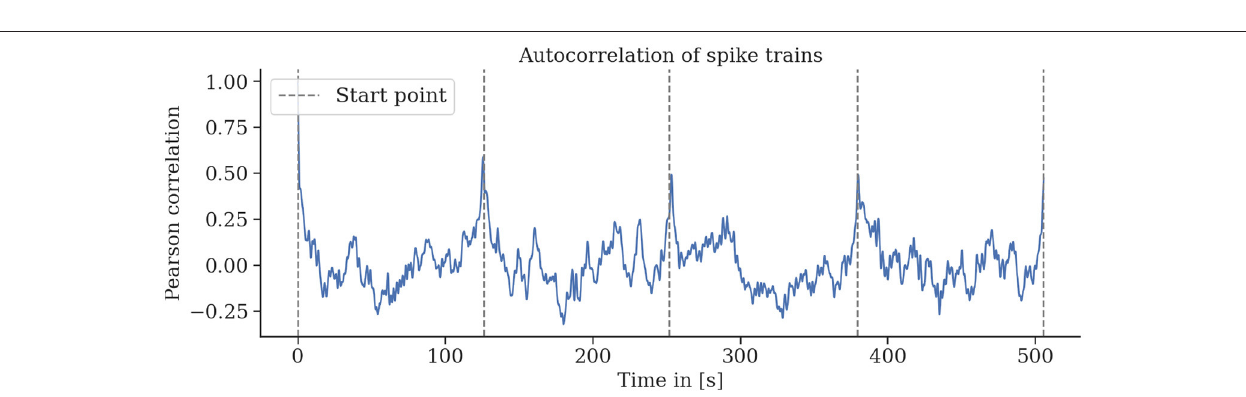
FIGURE 9 | Spike rates are strongly autocorrelated for multiple repetitions of the same flight trajectory. Sliding-window autocorrelations were computed for all rounds of six (a–f) flights. For all flights, particularly for flights a, b, and d, strong correlations of spike activity were observed for several rounds of the same flight trajectory. Gaps between rounds and the starting and landing periods were removed, and the sliding Pearson correlations were computed. Gray lines indicate the start of a